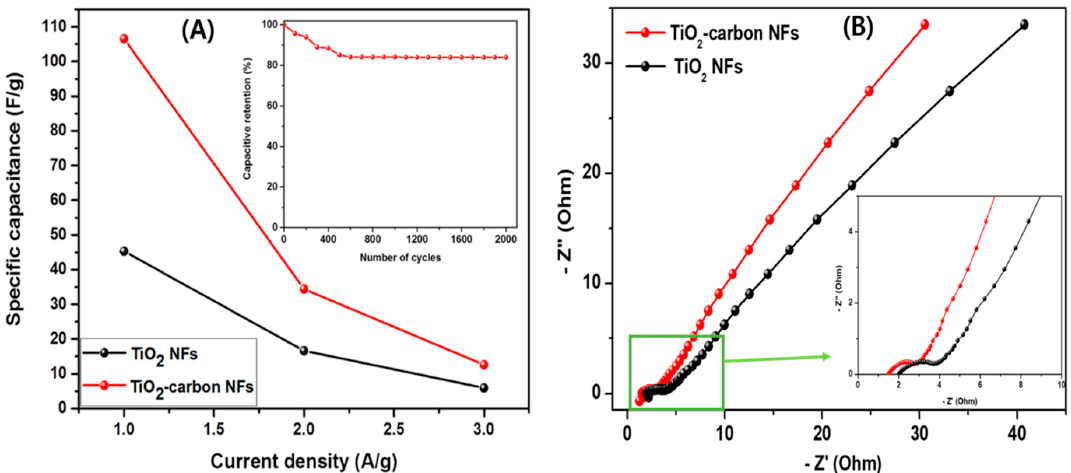
Figure 10. The specific capacitance ( A ) and electrochemical impedance spectroscopy (EIS) test ( B ) of different electrodes. Inset A and B represent the stability of the TiO 2 -carbon NF composite and semicircle area in the EIS spectra, respectively. Table 1. Comparison of the electrochemical performance of as-synthesized TiO 2 /carbon composite nanofibers for supercapacitor applications with some investigated electrodes. S. S. N.